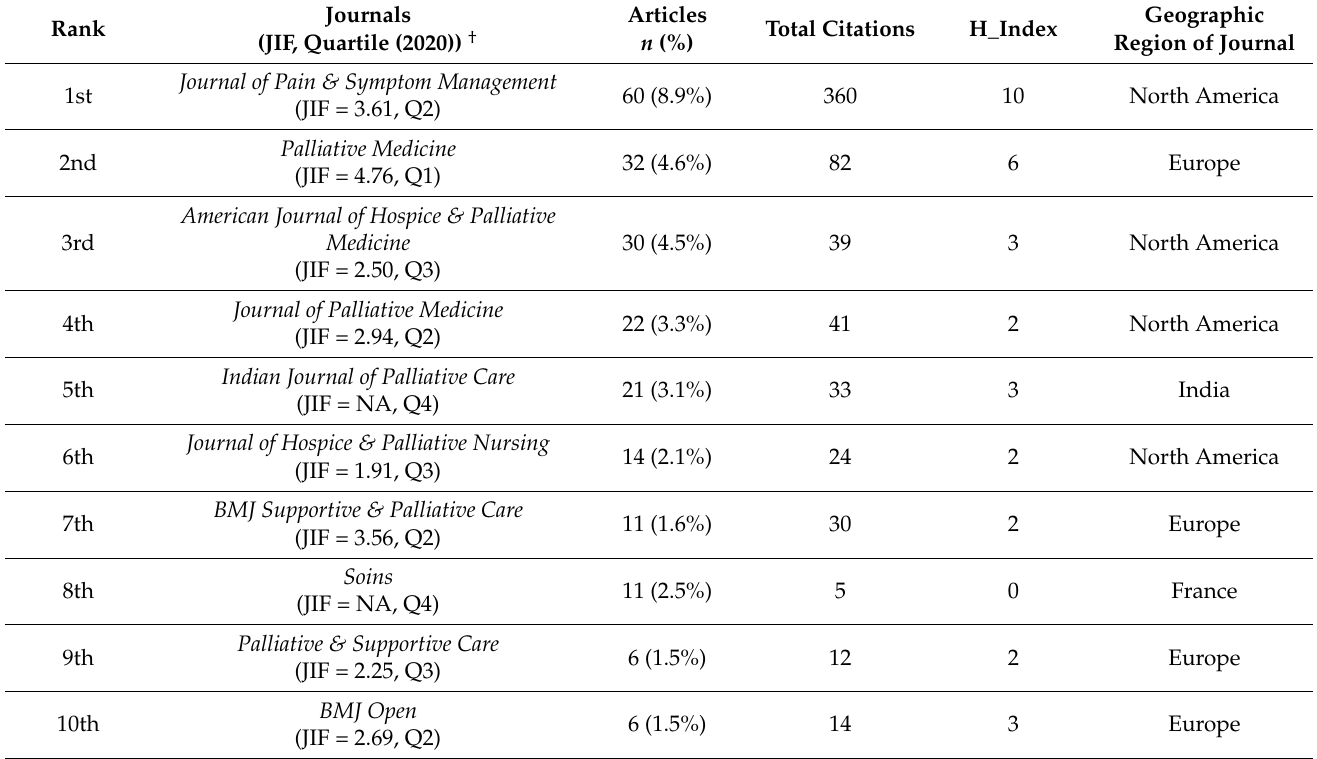
Table 2. Top 10 journals in the field of PC-related COVID-19